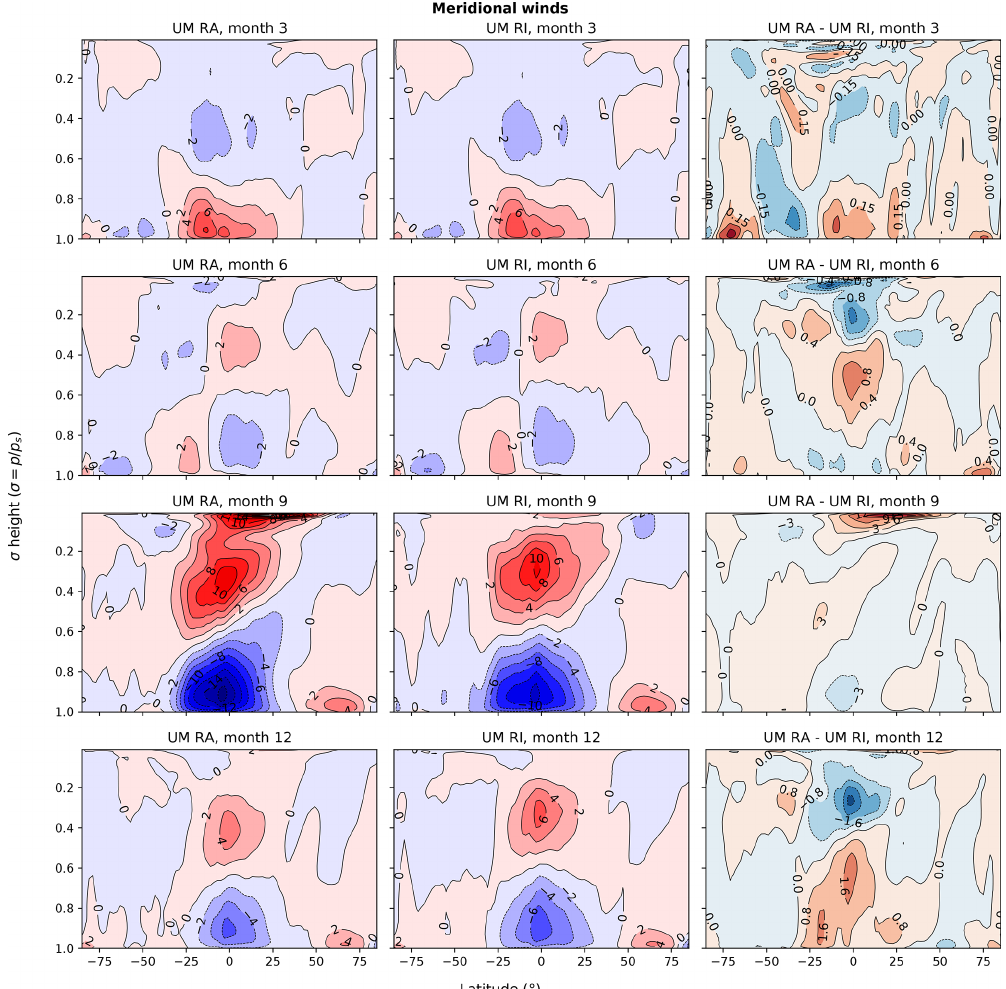
Figure A2. Zonal mean meridional winds (ms − 1 ) across four seasons within the Martian year. For each month, the time average is taken of all sols within that month. The RA dust scenario is shown on the left, the RI dust scenario in the centre and the differences between scenarios on the right. Colour scales in the left-hand and centre plots are matched across all months and between scenarios, with contour intervals of 2ms − 1 . The contours in the difference plots are not matched due to the varying intensity of the difference between months. Positive values indicate an eastward wind and negative values a westward